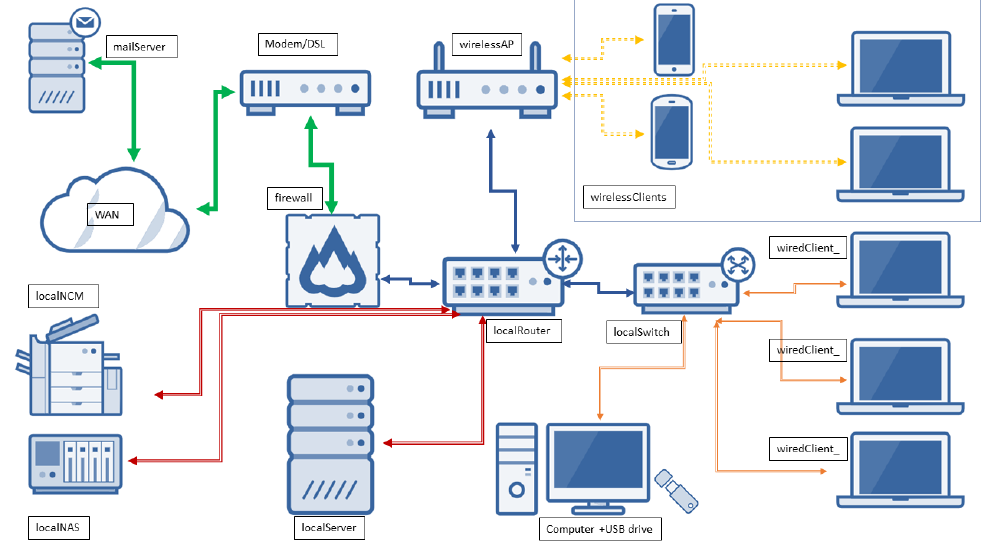
Figure 10. Typical network topology used by micro- and small-sized